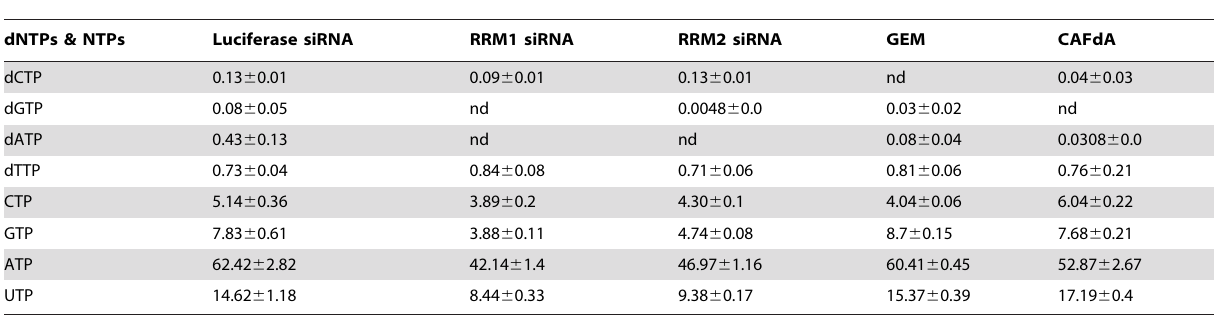
Table 1. Quantitation (AUC) of dNTP & NTP pools in the U20S cells.